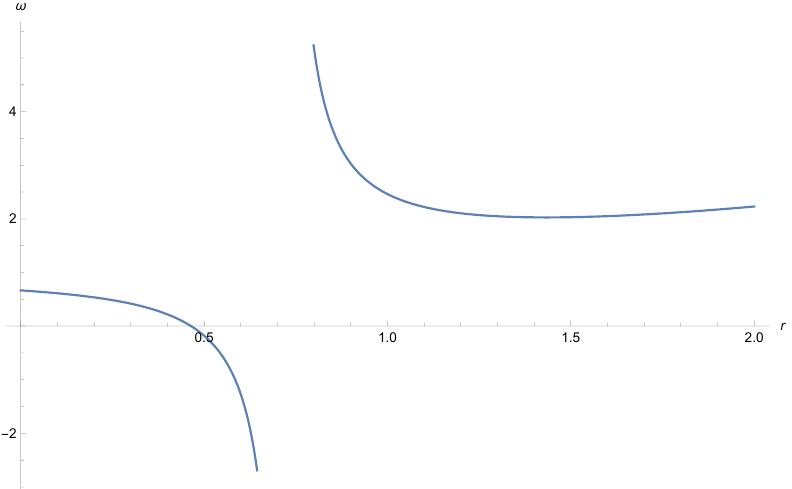
Figure 1. Plot of ω ( r ) for a zero-tidal Schwarzschild wormhole ( β = 0) in the ASG context for √ = 1/3. λ = 1( ξ = 2/3) and r 2 0